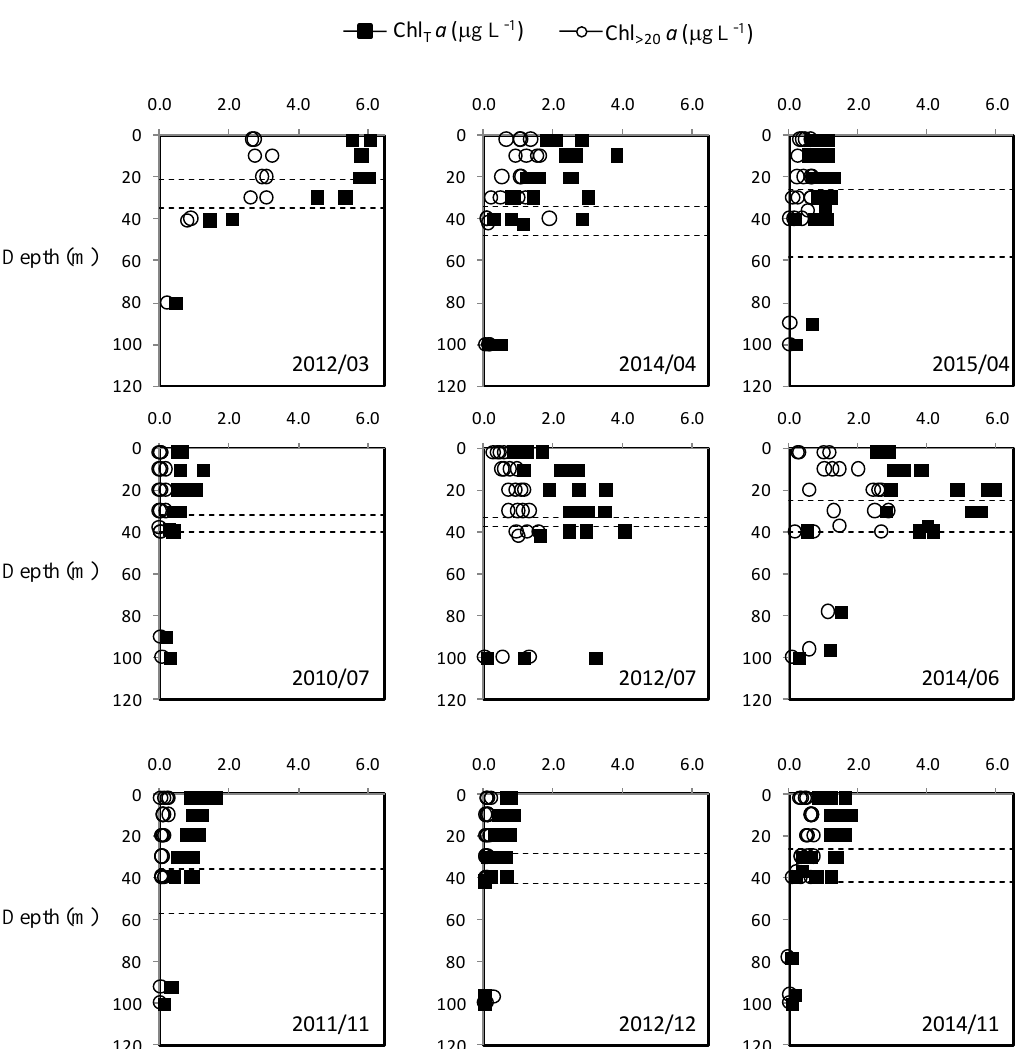
Figure 6. Variation along depth of total and >20 μ m chlorophyll a (Chl T a , fill symbols; Chl >20 a , open symbols) obtained during surveys in the Bay of Algeciras. For each depth, Chl T a and Chl >20 a values obtained in the four sampling stations are shown. The horizontal dashed lines show the variability range in the position of the euphotic layer lower limit. Data were grouped according to three seasonal periods: spring ( top ), summer ( middle ), and autumn ( bottom ).